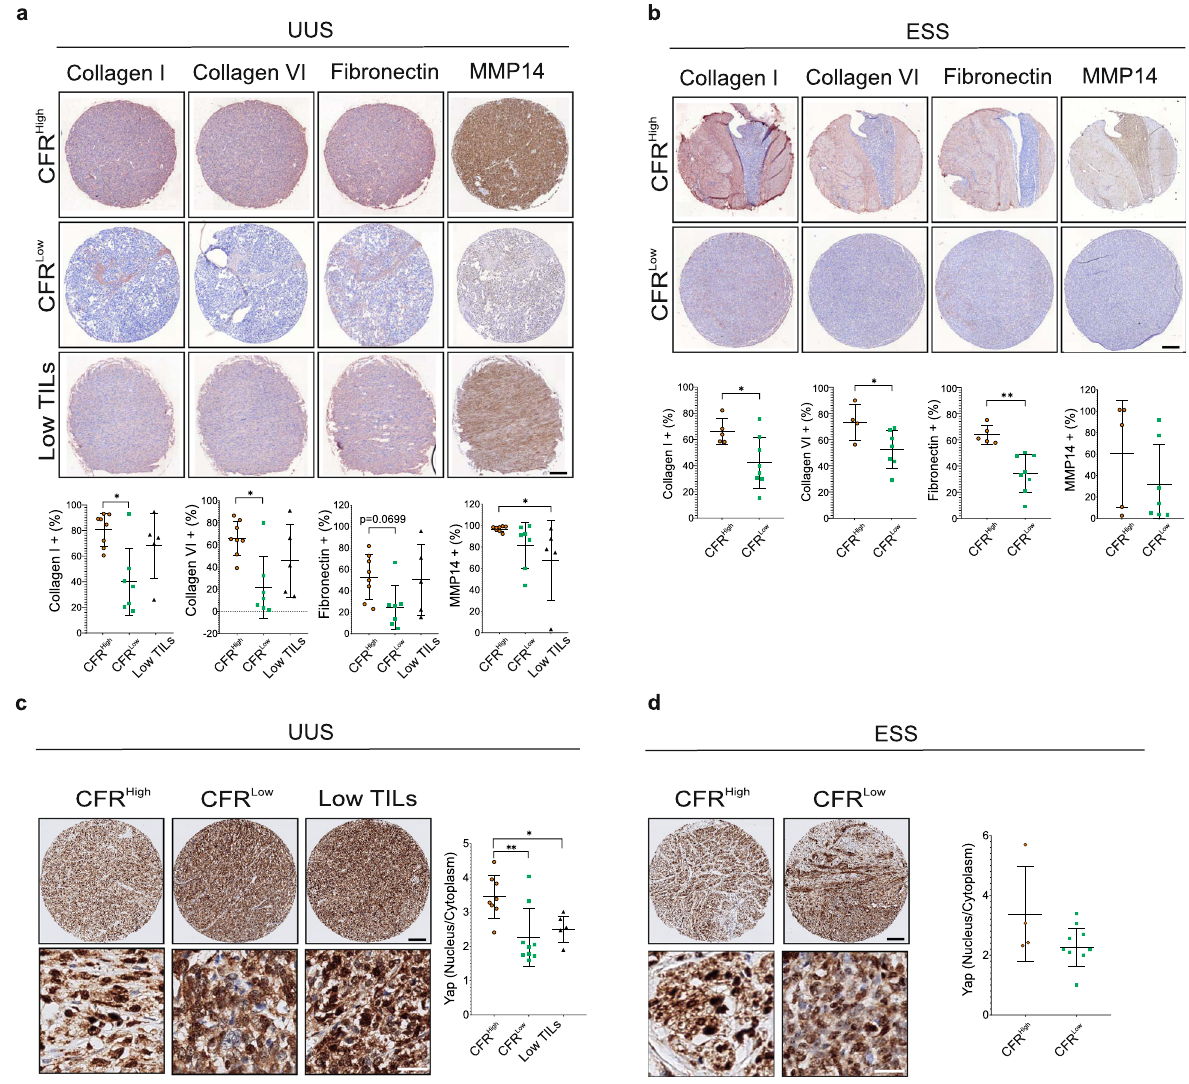
Fig. 6 ECM protein and nuclear YAP expression is enhanced in UUS and ESS tumors with high CFR. a , b Representative IHC images and quanti fi cation of indicated protein expressions show higher expression in the CFR High group in UUS ( a ) and in ESS patients ( b ). Scale bars indicate 100 μ m. c, d Representative IHC images of YAP expression and quanti fi cation of its nuclear/cytoplasmic ratio shows a higher ratio in the CFR High patient group in UUS ( c ) and in ESS patients ( d ). Upper panels scale bars indicate 100 μ m and lower panels scale bars indicate 20 μ m. Plots indicate average ± s.d. Signi fi cance test is indicated *( P < 0.05), **( P <